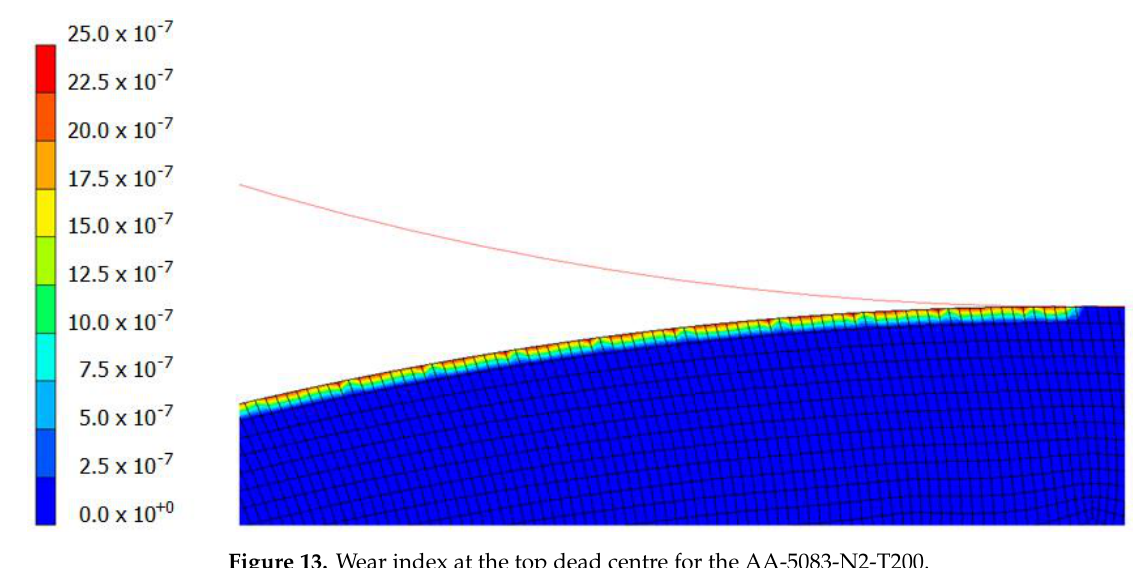
Figure 13. Wear index at the top dead centre for the AA-5083-N2-T200.